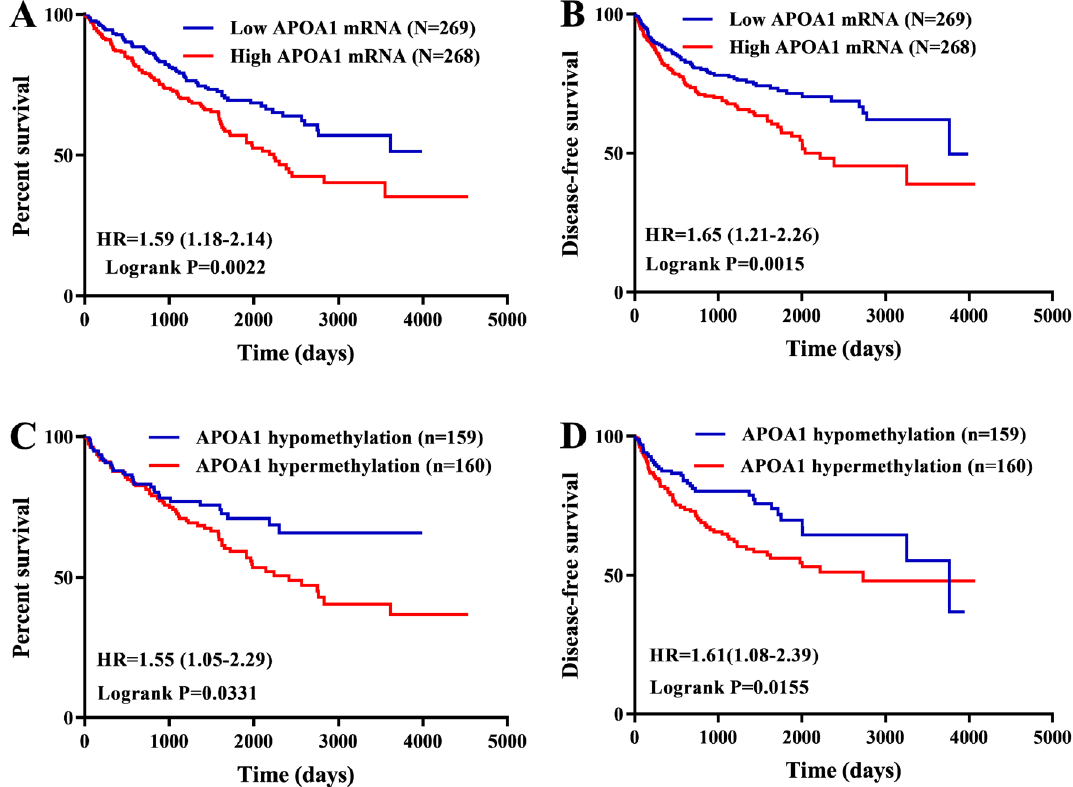
longer overall survival ( C ) and disease-free survival ( D ) time than those with APOA1 hypermethylation (N =